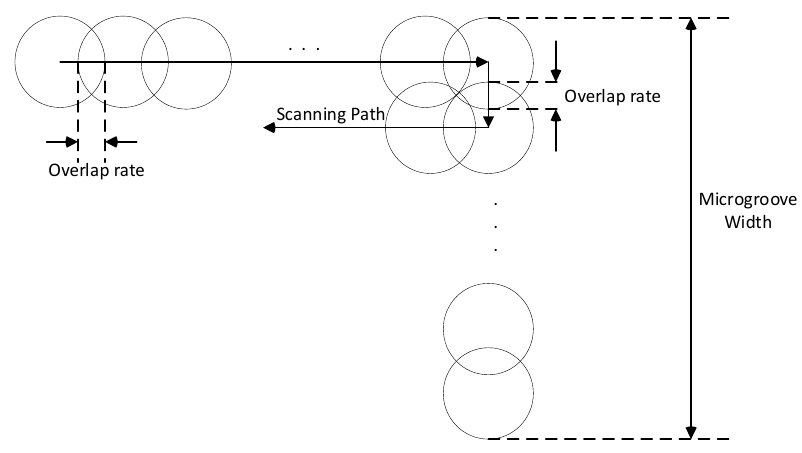
Figure 5. Determination of sweep line number and spacing.